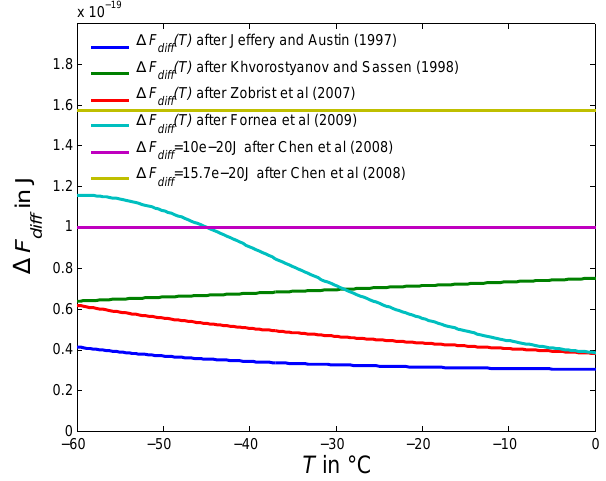
Fig. A2. Energy for diffusion across the liquid-ice boundary 1F diff as used in different immersion freezing formulations of classical nucleation